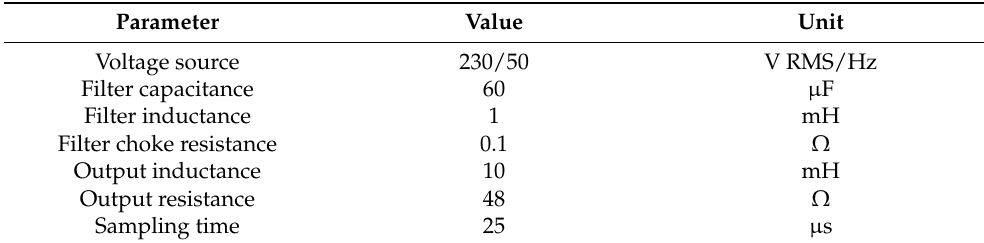
Table 1. Parameters of simulation model.